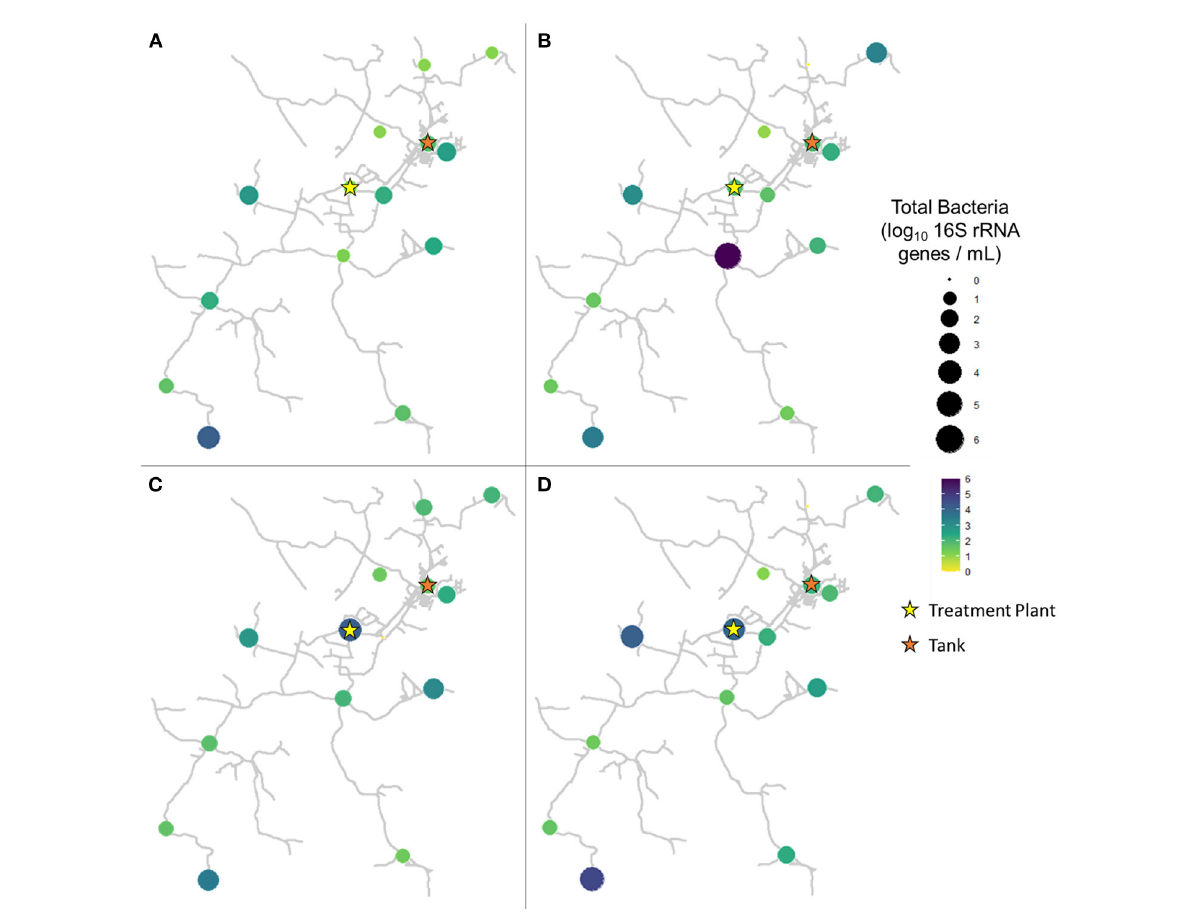
FIGURE3 Total bacteria in samples collected at all sites in (A) March (2 weeks before flushing), (B) April (1 week after flushing), (C) June (9 weeks after flushing), and (D) August (16 weeks after flushing).